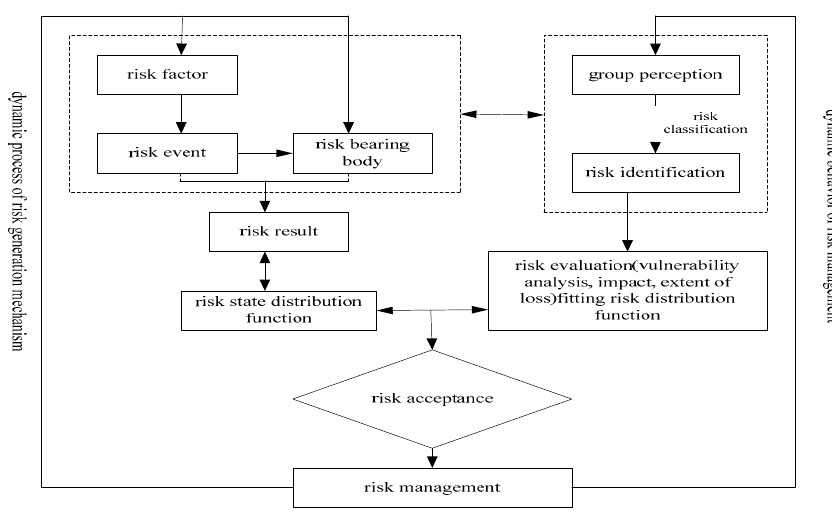
Figure 1. Sketch of risk characterized as a dynamic process.